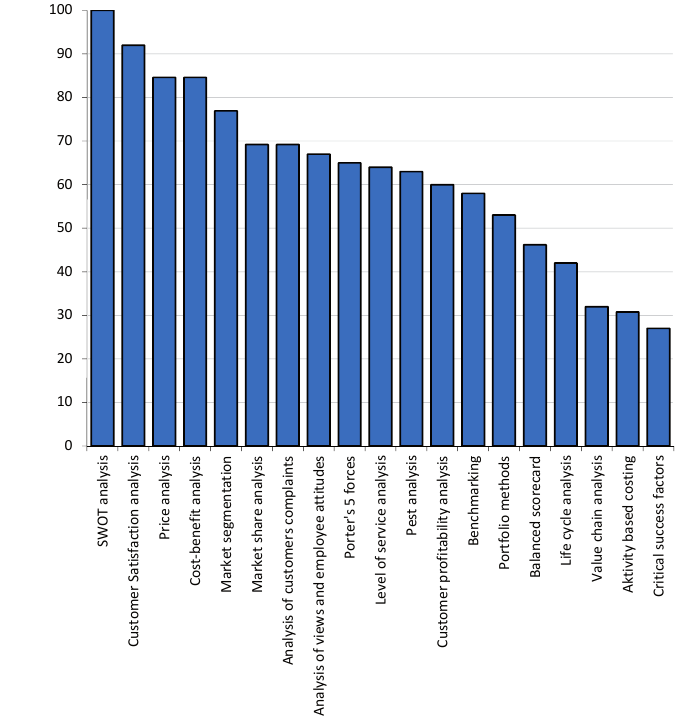
Fig. 1 – Use of strategic management tools and techniques. Source: Own